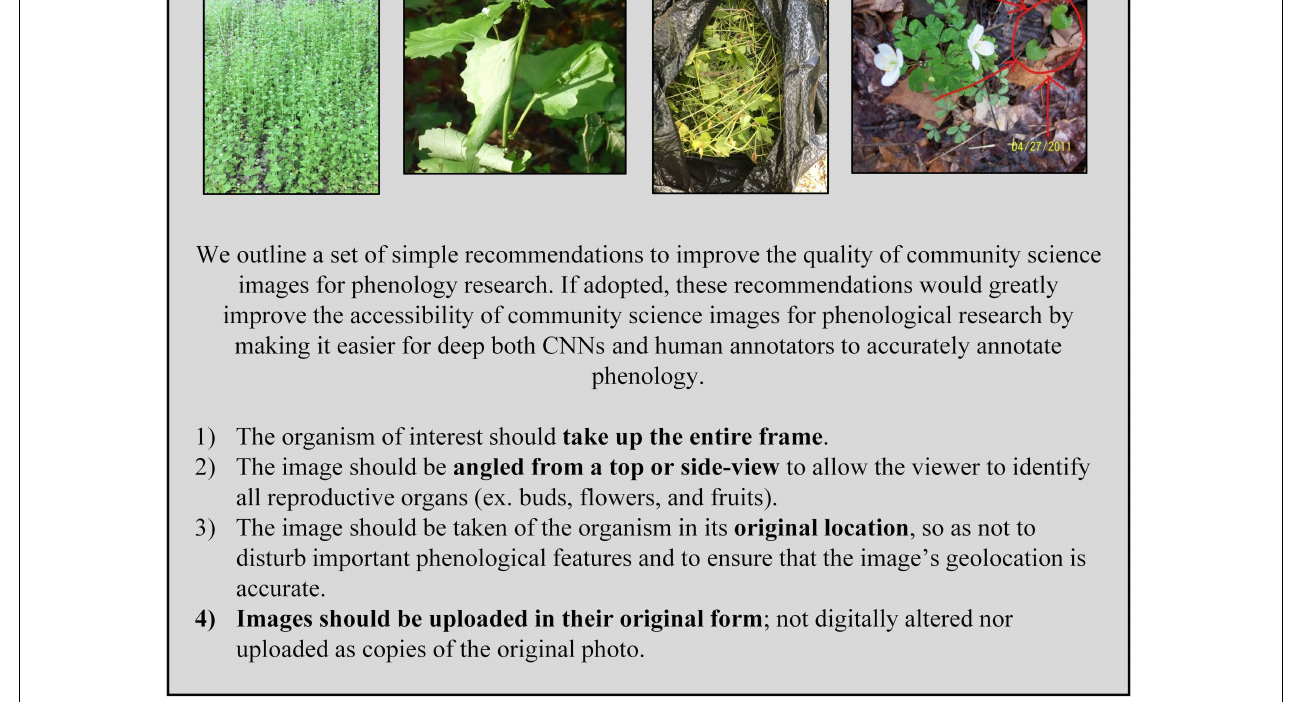
FIGURE 5 | Description of preferred vs. non-preferred community science images for use in phenology research. Example images were sourced from iNaturalist. Image credit (iNaturalist username): (a) szuwarek; (b) deannahunt; (c) midnight_jim; (d) pedropedreiro; (e) pleasethetrees; (f) ny_wetlander; (g) r_rogge; (h)